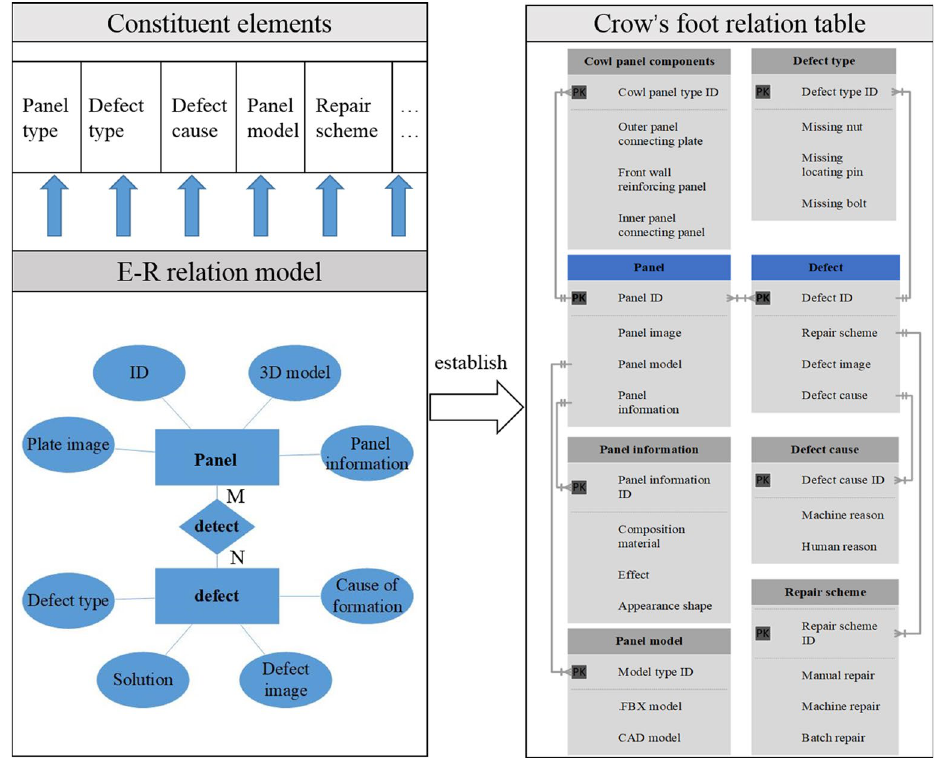
Figure 2. Construction of body in the white digital twin knowledge